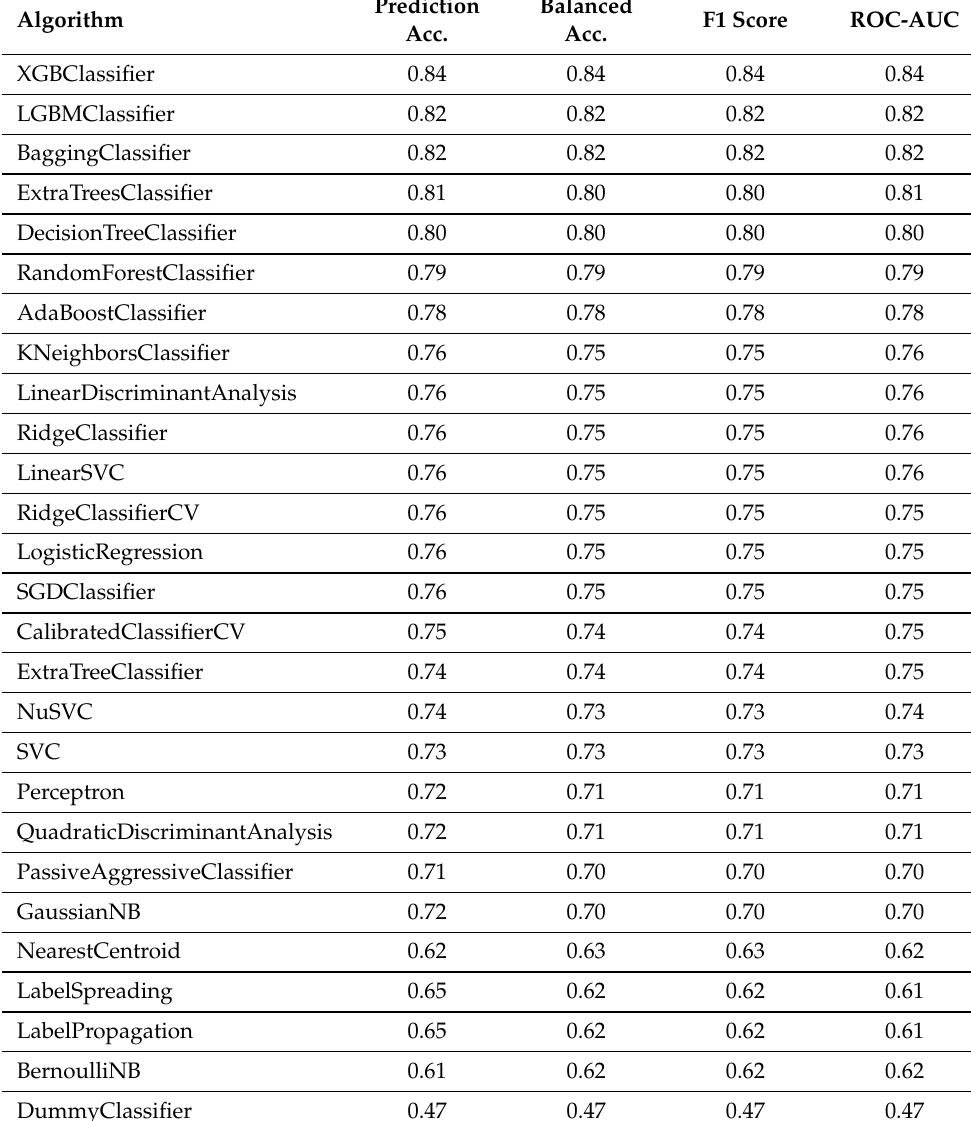
Table 2. Evaluation results per shallow ML algorithm. The classifiers are ordered based on the accuracy